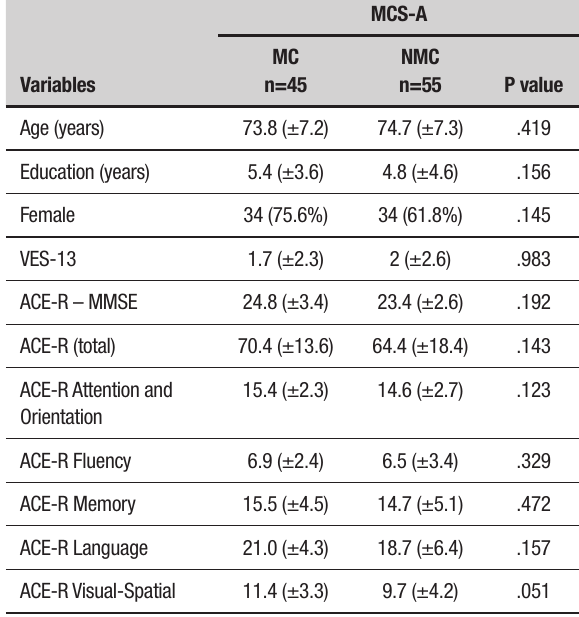
Table 2. Clinical characteristics of final sample of people aged 65+ living in